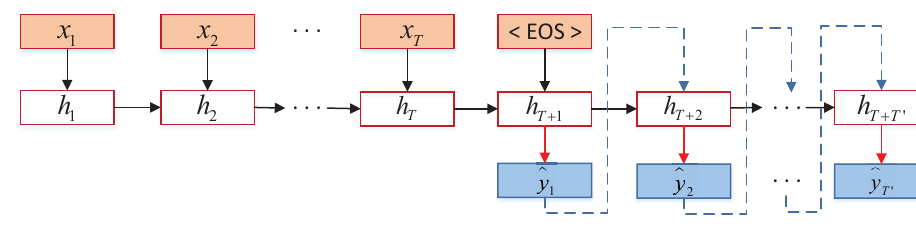
Figure 2. Encoder–decoder